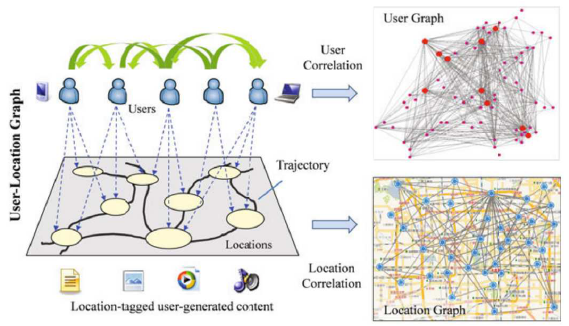
Fig. 1 User-location graph for a Location-Based Social Network (LBSN), comprising user and location correlations [14]